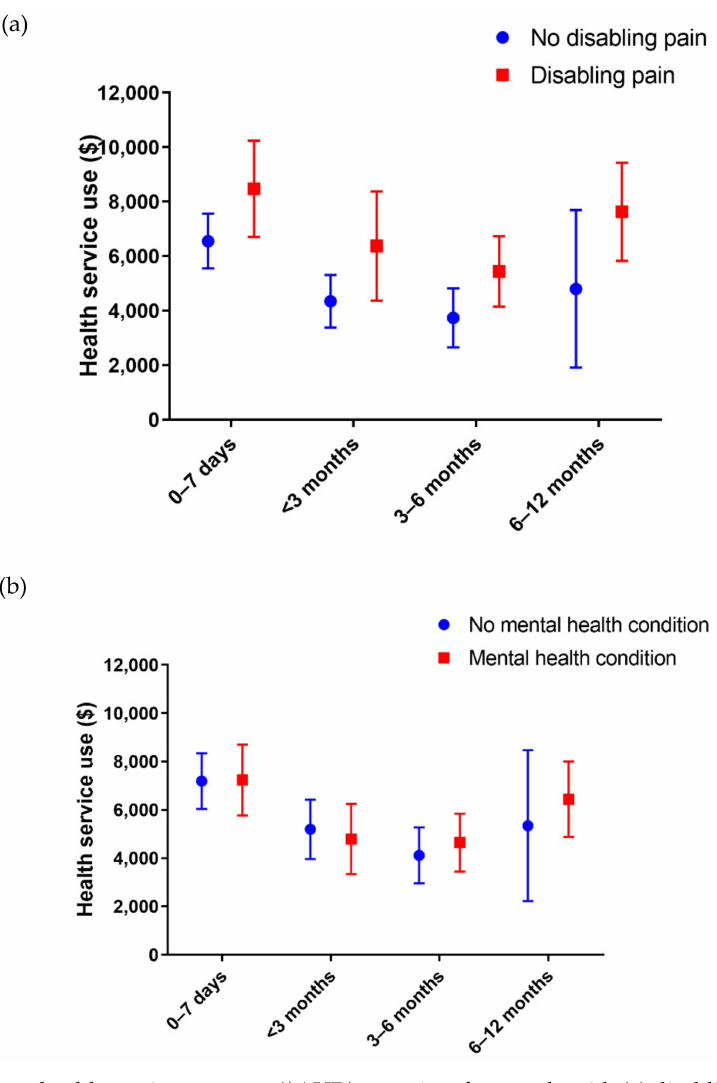
Figure 2. Average health service use costs ($AUD) over time for people with ( a ) disabling pain or ( b ) mental health (MH) conditions indicated relative to people without the respective condition. Mean + 95% CI.